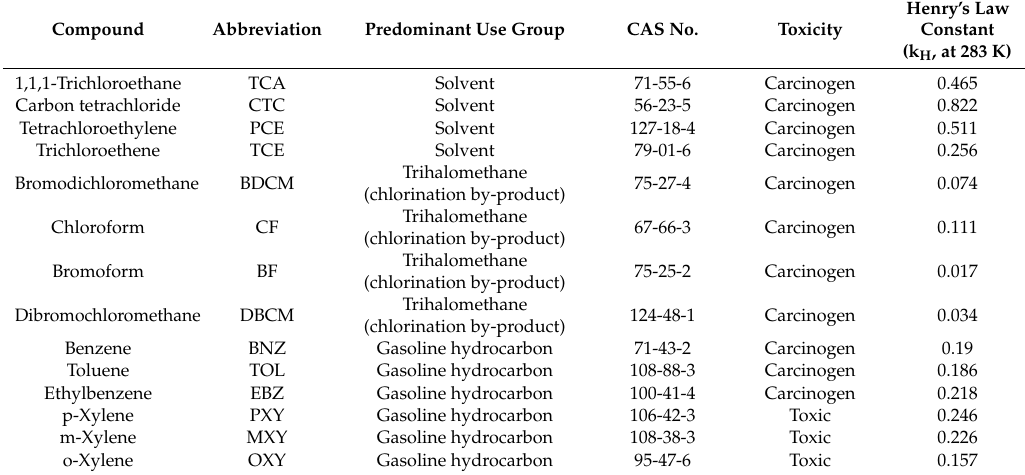
Table 1. Properties of the 14 volatile organic compounds (VOCs)